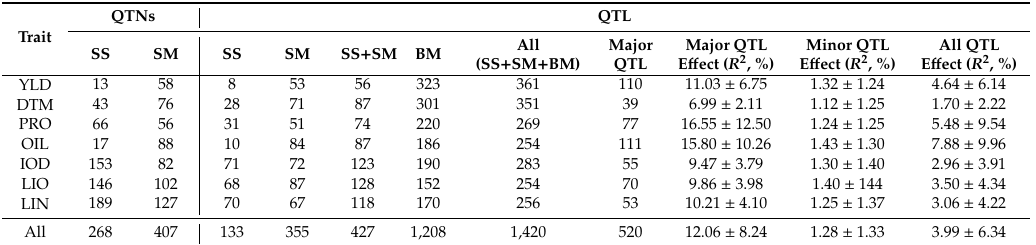
Table 2. Quantitative trait nucleotides (QTNs) / quantitative trait loci (QTL) identified from 17,277 single nucleotide polymorphisms (SNPs) in the 260 lines for the seven traits using three types of genome-wide association study (GWAS) models.